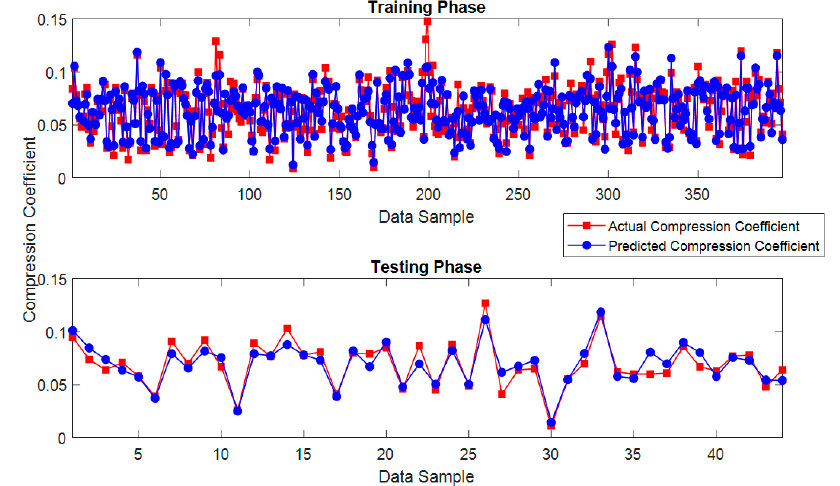
Figure 8. The performance of the proposed ABC-LM-ANN model used for predicting CC.